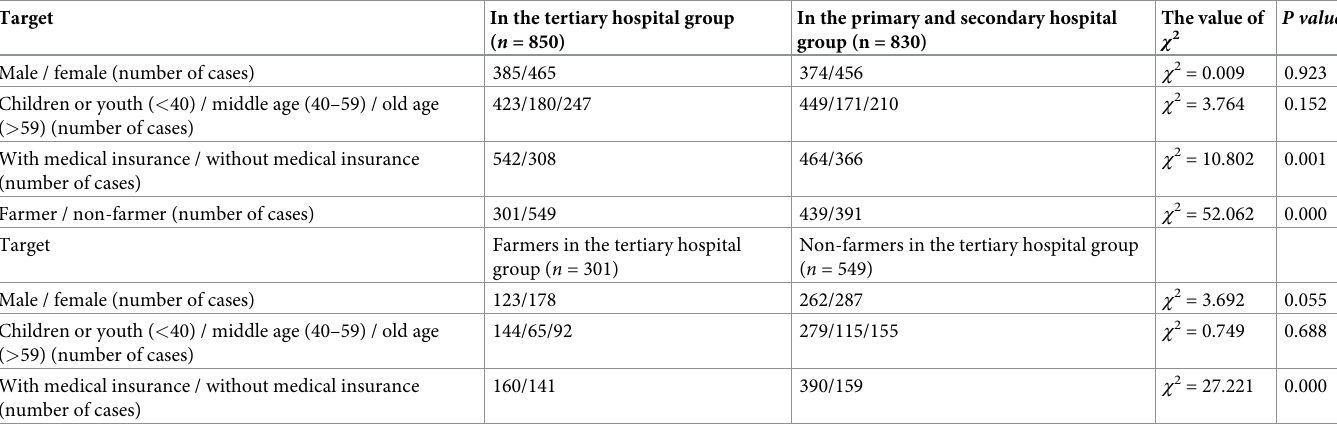
Table 3. Comparison of outpatients’ target data between the group of tertiary hospitals and that of primary and secondary hospitals groups.